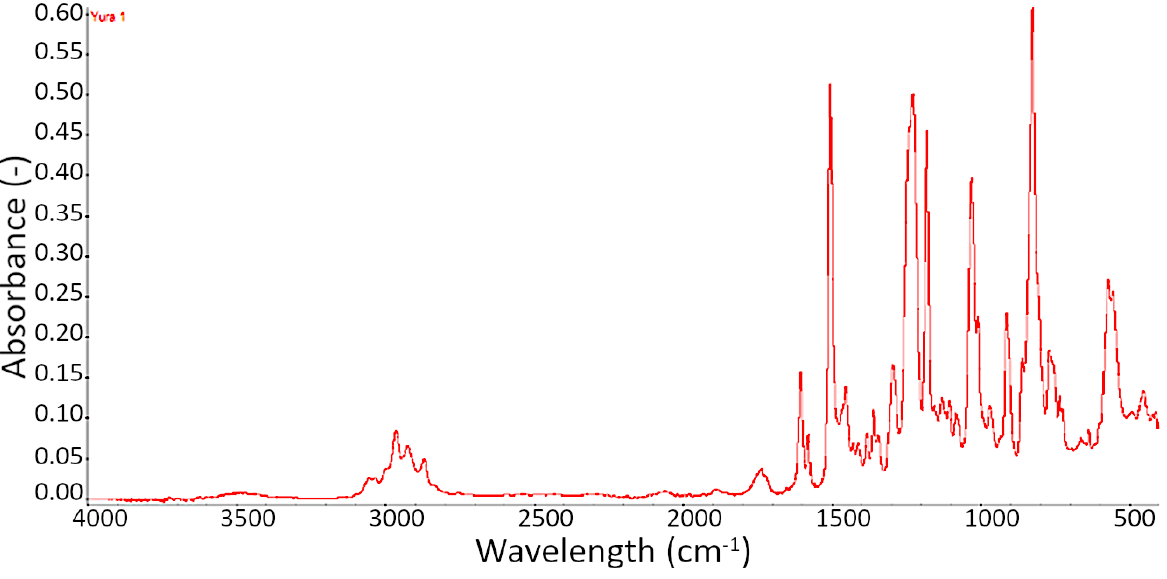
Figure 6. FT-IR spectrum of ED-20 resin. In this spectrum belonging to ED-24 AK modified resin (Figure 7), one can observe both peaks originating from ED-20 (Epidian 5) and those typical for adipic acid at around 1700, 1450, 750, and 550 cm − 1 .